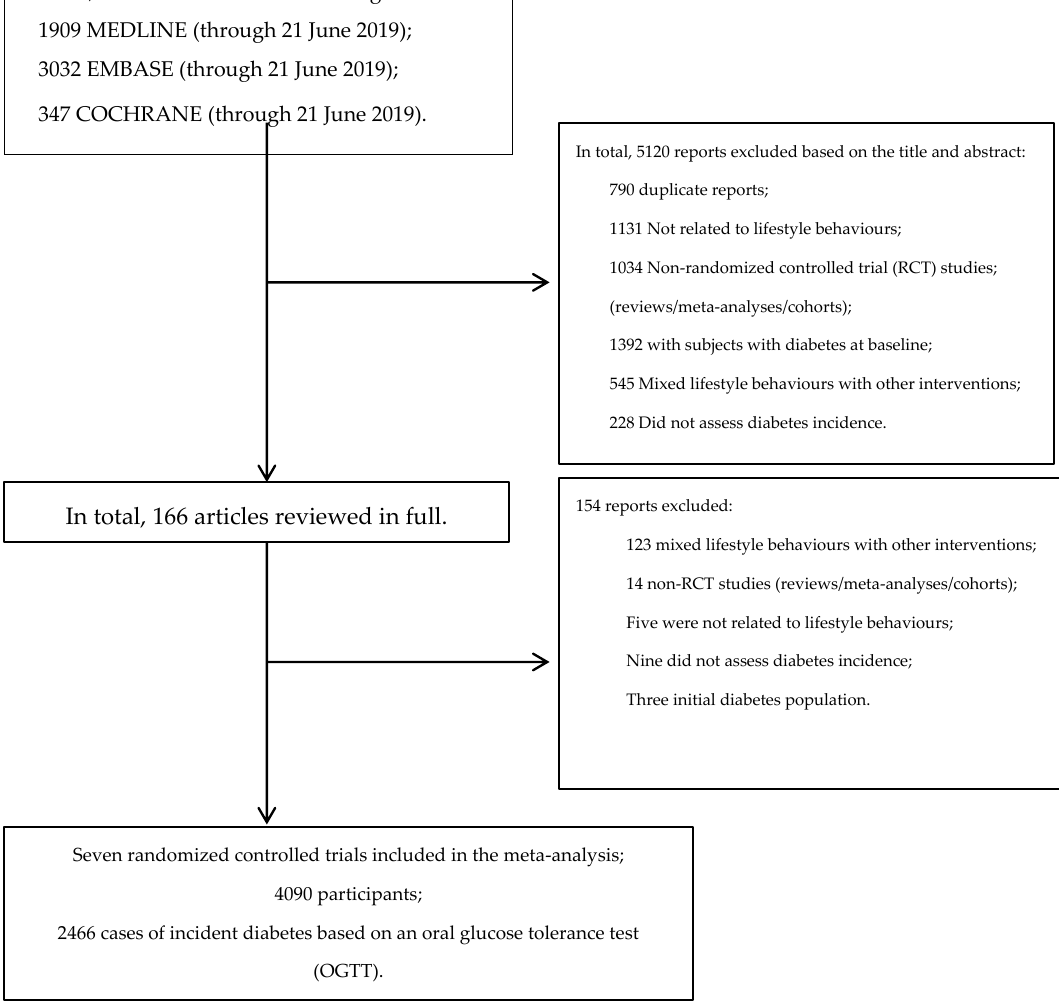
Figure 1. Flow diagram outlining the systematic search and article selection process.